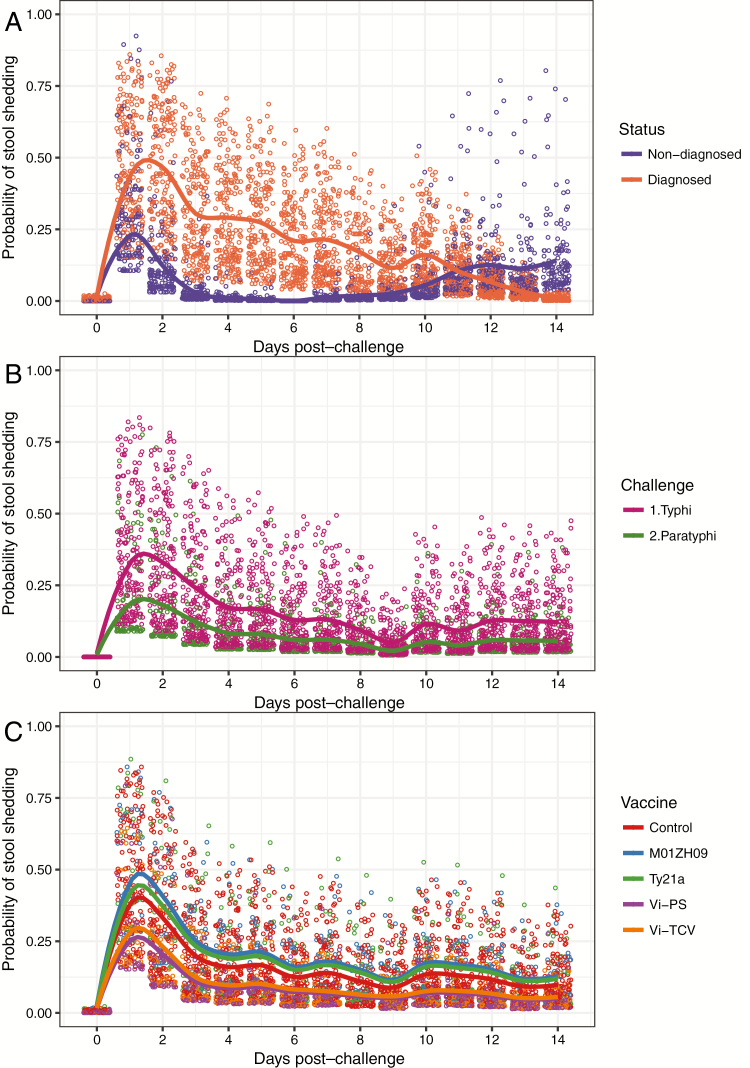
Probability of bacterial shedding in stool by day in controlled human infection enteric fever studies. (A) N = 331 participants challenged with Salmonella Typhi according to diagnosis status. Nondiagnosed N = 145, diagnosed N = 186. (B) Unvaccinated participants exposed to oral challenge with S. Typhi (N = 197) or S. Paratyphi (N = 109) bacteria. (C) Vaccinated and unvaccinated participants challenged with 1–5 × 104 colony-forming units S. Typhi wild-type bacteria according to vaccine received. Control vaccine or no vaccine (N = 158); M01ZH09, experimental typhoid vaccine (N = 32); Ty21a, live attenuated oral typhoid vaccine (N = 30); Vi-PS, Vi-polysaccharide typhoid vaccine (Typhim Vi®, Sanofi Pasteur; N = 35); Vi-TT, Vi-tetanus toxoid conjugate vaccine (TypbarTCV®, Bharat Biotech; N = 37)